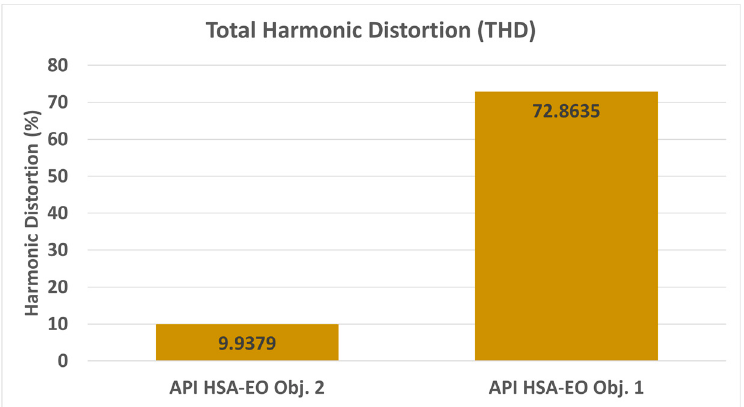
Figure 27. THD percentage of the two controllers under faulty operation.